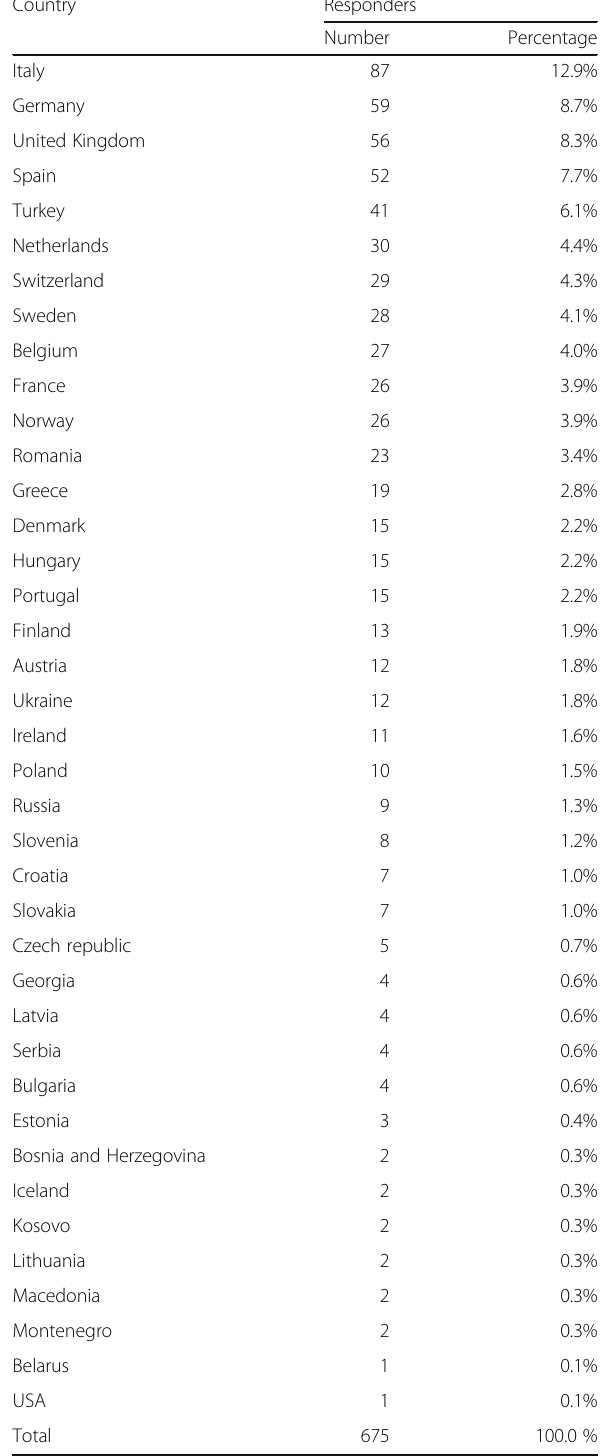
Table 3 Survey responders by country Country